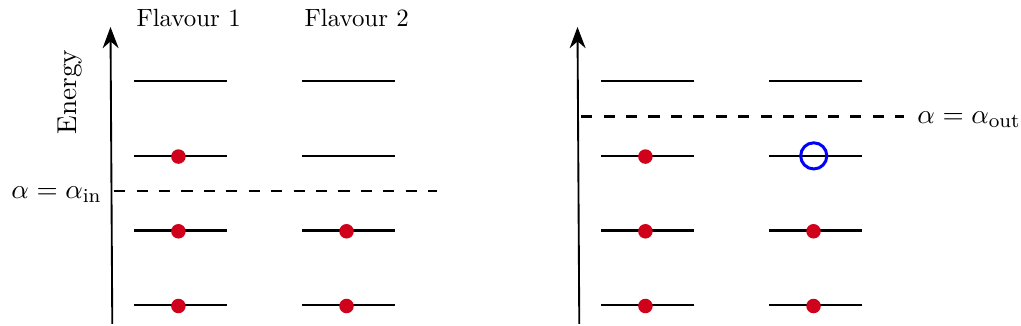
Figure 1 . The fermion spectrum before and after the scattering for N = 2 . Left: initial state; = 1 , n in = 0 . All the negative states and the one flavour 1 positive energy state are occupied. n in 1 2 Right: a candidate of the final state; n out = 0 , n out = − 1 , which is interpreted as one anti-particle 1 2 state of flavour 2 and is represented by the blue circle. We emphasise that, since the scattering is not adiabatic, this is not necessarily a true final state. The point here is that there are candidates for the final